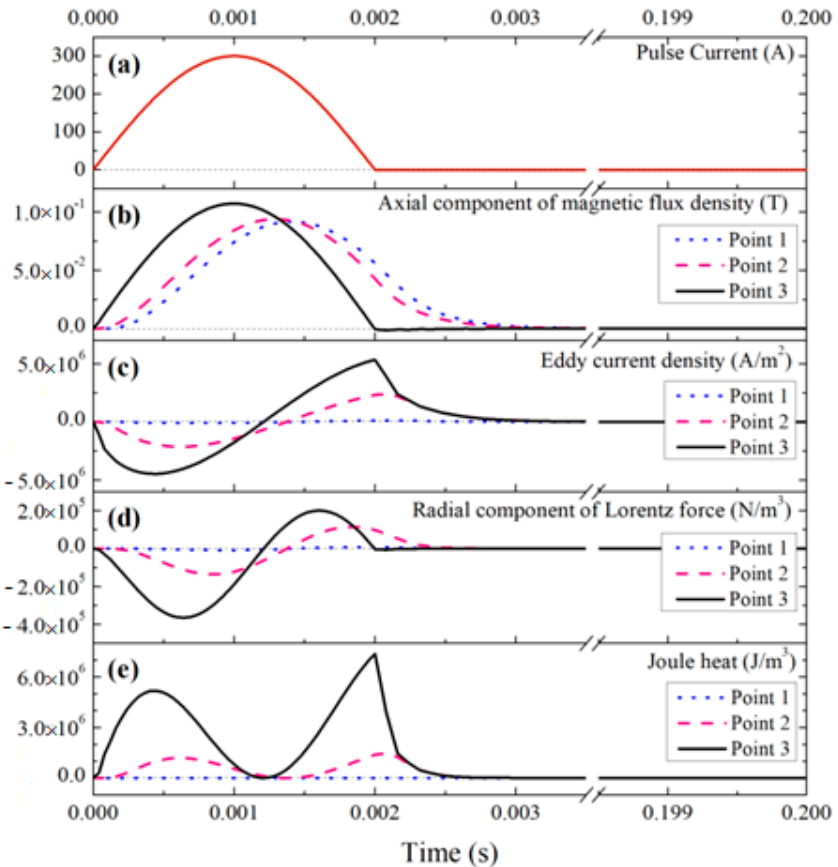
Figure 26. Results of modeling ( a ) the current of the exciting pulse in the coil; ( b ) the axial component of the magnetic flux density; ( c ) eddy current density; ( d ) the radial component of the Lorentz force; and ( e ) Joule heat at points 1–3 (1 cent of the melt, 2 half the radius, and 3 at the wall of the mold) [100].